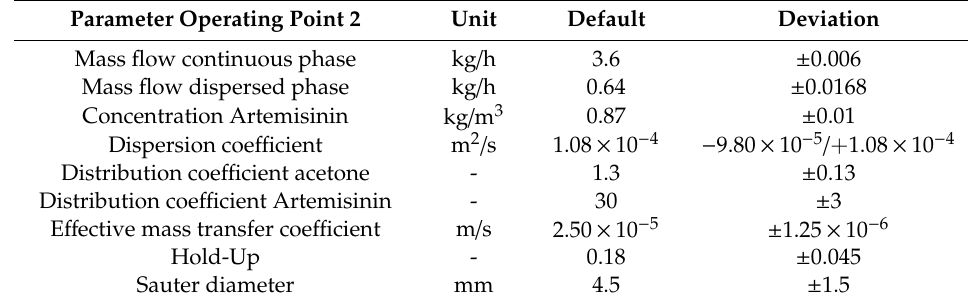
Table 5. Axial dispersion model parameters for optimized operating point study. The default values of the simulation equal the experimental process